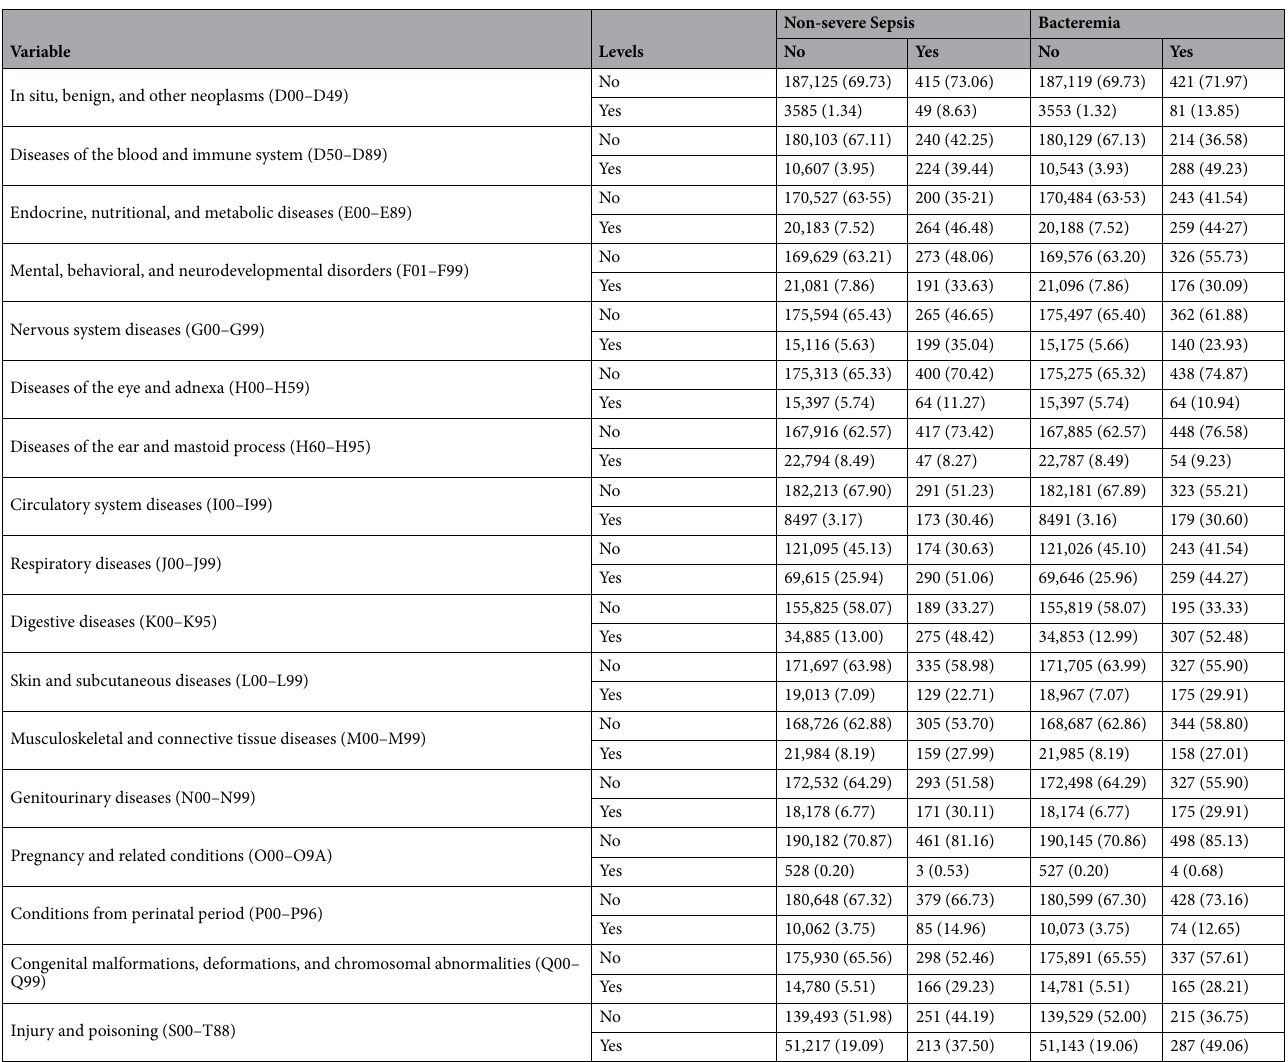
Table 2. Summary statistics: non-severe sepsis and bacteremia.